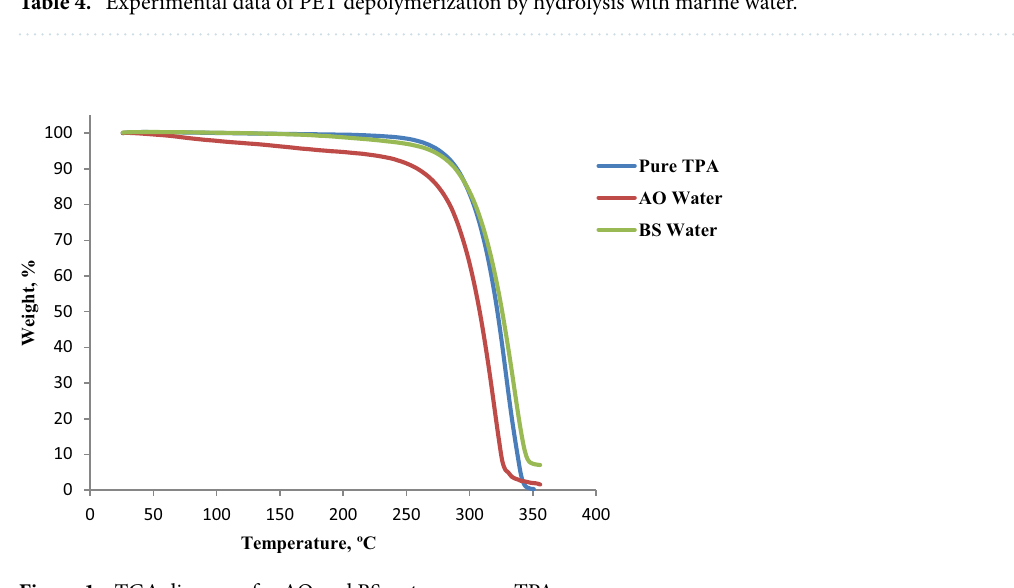
Figure 1. TGA diagrams for AO and BS water vs. pure